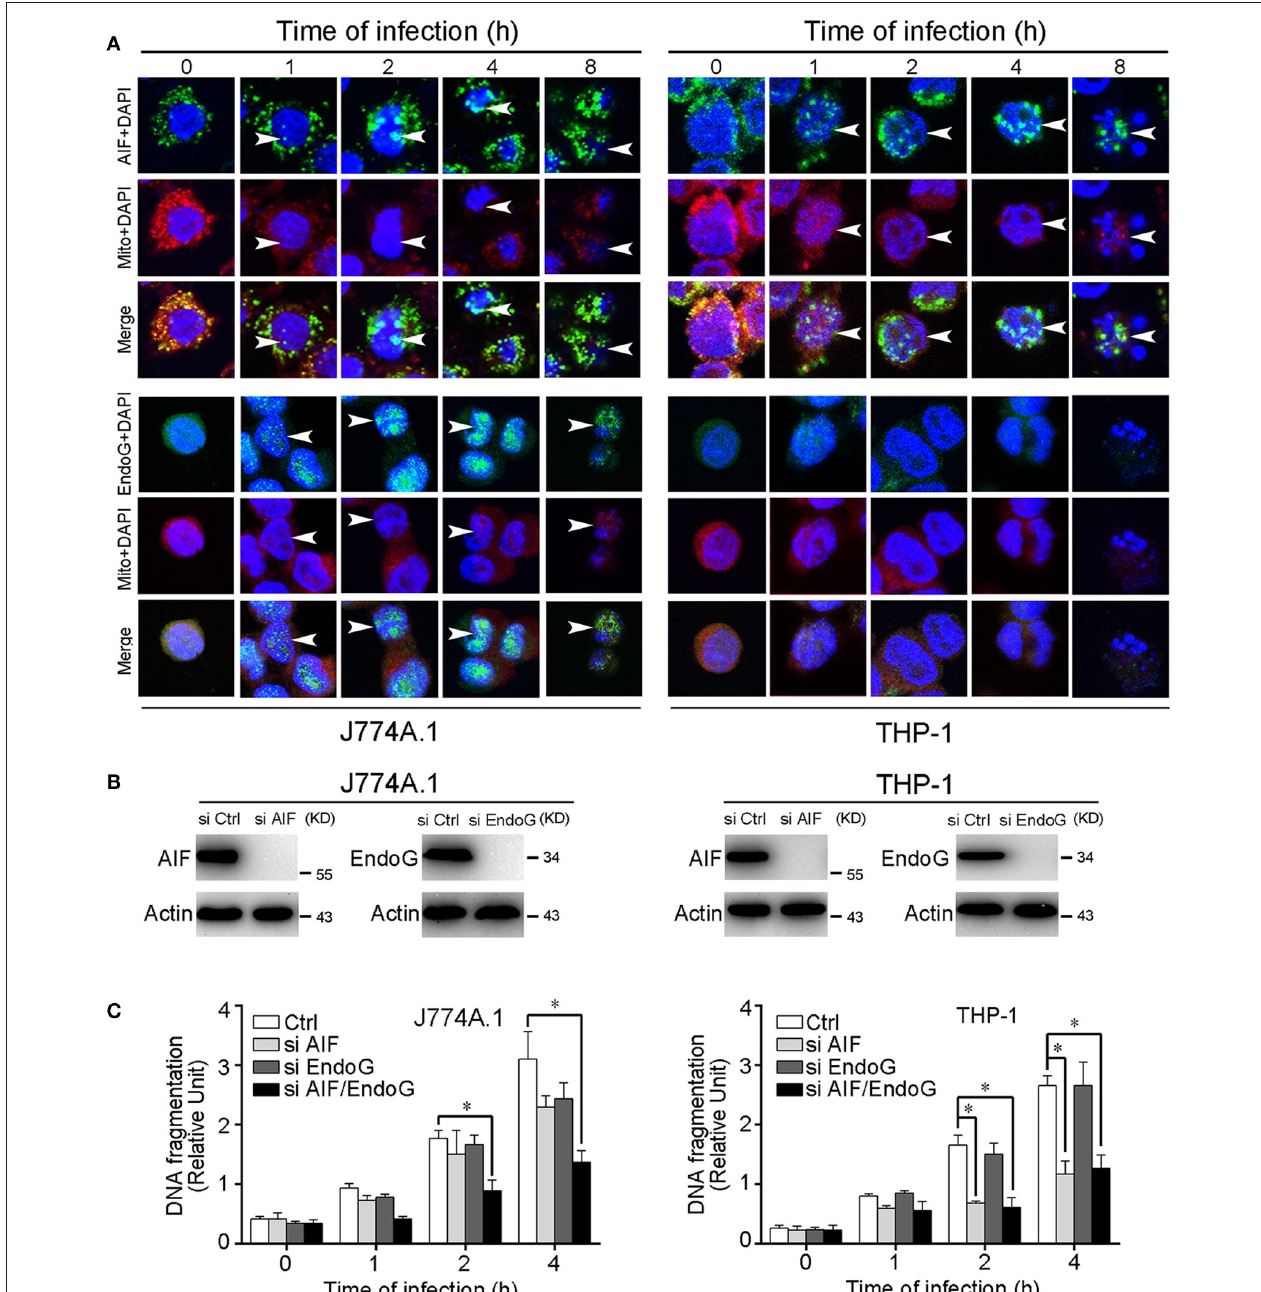
FIGURE 3 | Nuclear translocation of AIF, EndoG, and the DNA fragmentation in leptospire-infected macrophages. (A) The representative nuclear translocation of AIF and Endo-G in J774A.1 and THP-1 cells infected with L. interrogans strain Lai for the indicated times. The small green points indicate AIF or EndoG protein stained with FITC-conjugated antibody. The red points indicate the mitochondria stained with MitoTracker Red CMXRos. The blue spots indicate nuclei stained with DAPI. Arrows: AIF or EndoG nuclei translocation. (B) The expression of AIF and EndoG in siRNA pretreated J774A.1 and THP-1 cells. Macrophages were transfected with Ctrl siRNA, si AIF or si EndoG, and then infected with leptospires for 4h. (C) DNA fragmentation in siRNA pretreated J774A.1 and THP-1 cells infected with L. interrogans strain Lai. Cells pretreated with Ctrl siRNA, si AIF, si EndoG, or both si AIF and si EndoG were infected with leptospires for the indicated times. Bars show the mean ± SD of three independent experiments. * p < 0.05 for comparison with the cells transfected with Ctrl siRNA. All data are representative of three independent experiments.